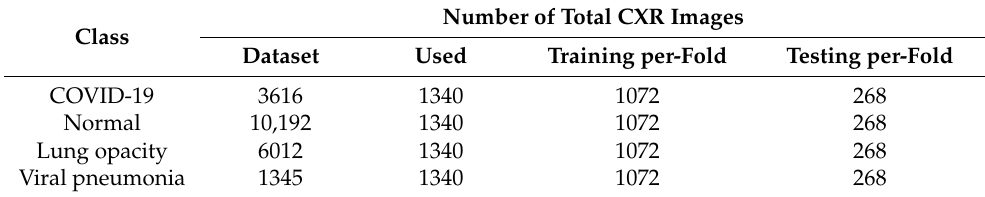
Table 1. Total number of chest X ‐ ray images per ‐ class and per ‐ fold.